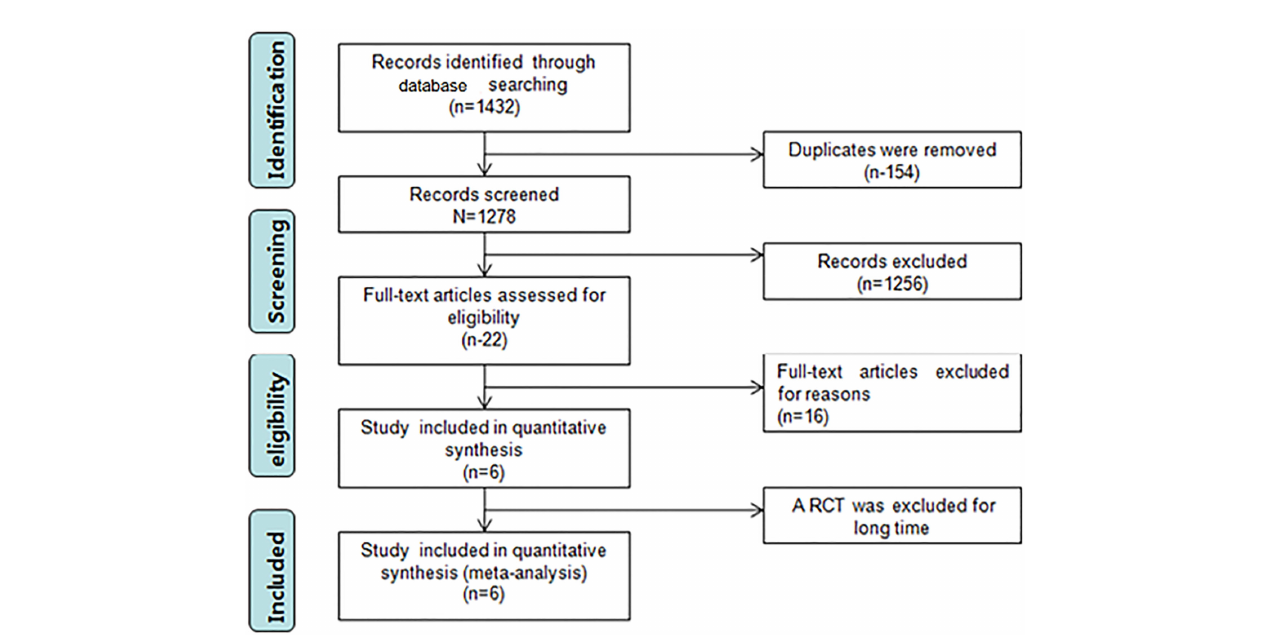
FIGURE 1 PRISMA fl owchart summarizing the study selection process. The enrolled studies represent a total of 6 RCTs and encompass 207 patients with ERCP and 200 patients with PTCD. After quality assessment, all studies were interpreted as high-quality studies. The characteristics of the studies are depicted in Table